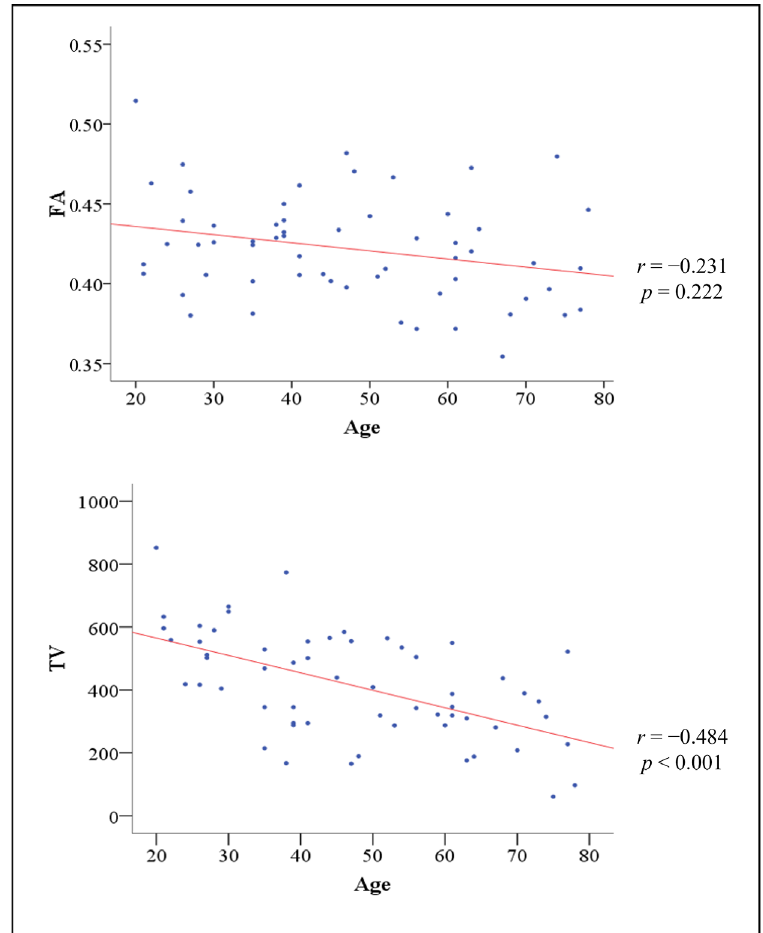
Figure 2. Correlations between the age of all subjects and the two DTT parameters. Table 1. Mean values of diffusion tensor tractography parameters of the nigrostriatal tracts. Young Middle